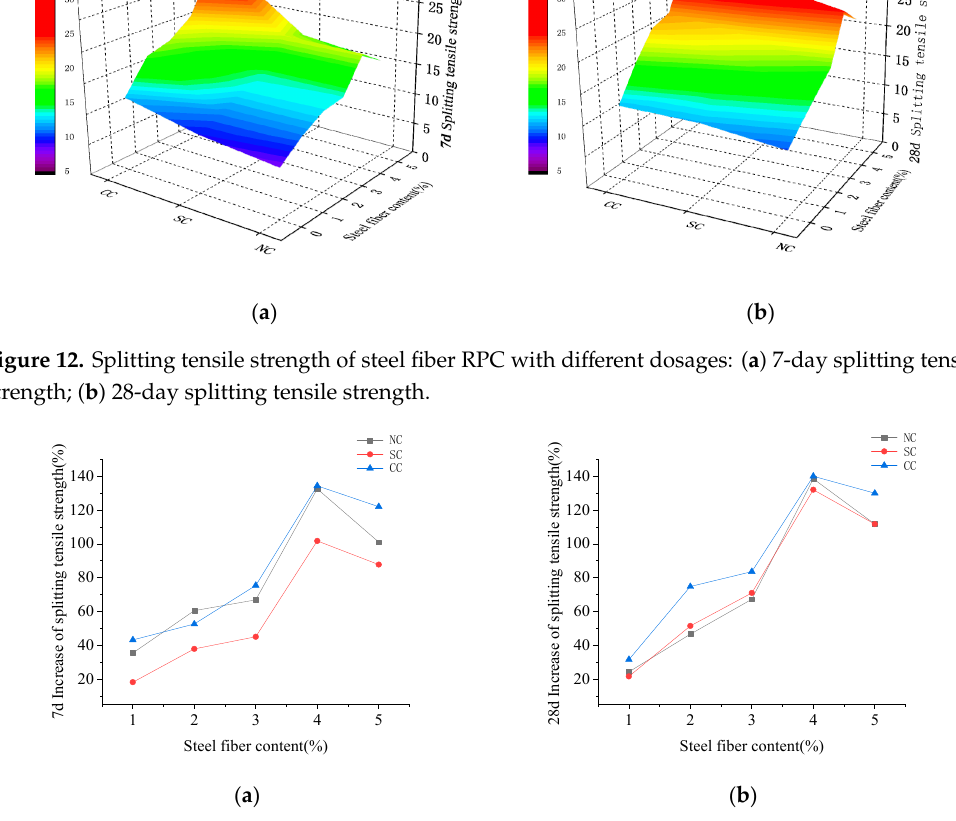
Figure 13 . Percentage of splitting tensile strength improvement of steel fiber RPC with different dosages of steel fiber after ( a ) 7-day curing and ( b ) 28-day curing.